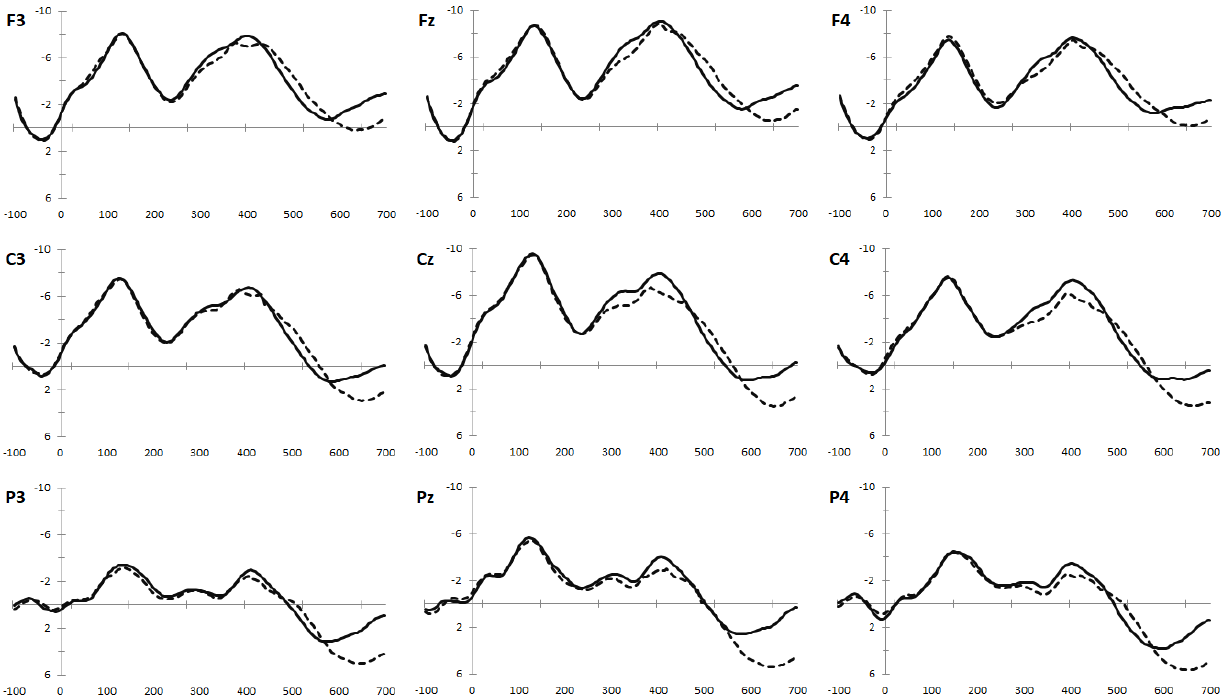
Figure 1. Grand average ERP waveforms for form-unrelated (dotted lines) and form-related words (solid lines) in Experiment 1. ERPs are plotted for nine equidistant representative electrodes within each region of interest. Negative voltage is plotted up. Onset of the Spanish word (i.e., the target) is indicated by the vertical calibration bar. Data are plotted from 100 ms prior to and 700 post stimulus onset.